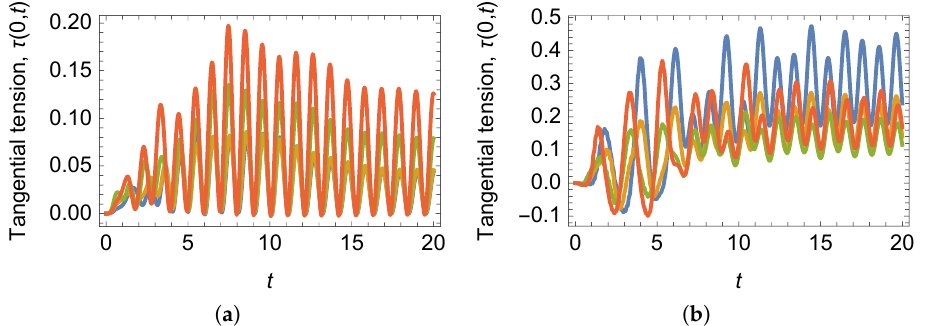
Figure 5. Evolution of the tension τ at the base: ( a ) rotation coupling and ( b ) curvature coupling. The response of the actuated filament is the one in green.